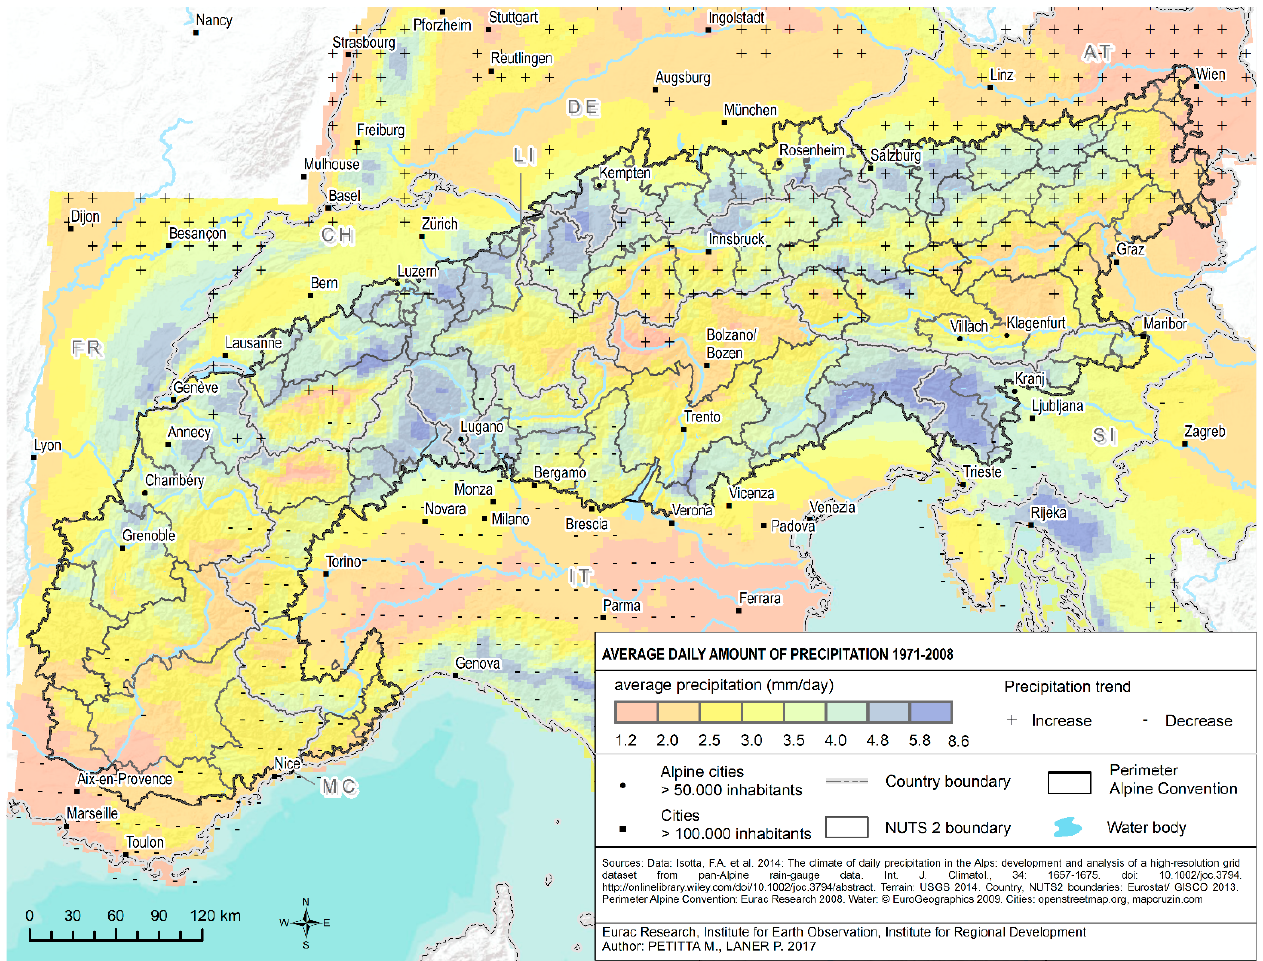
Figure 2. The average of cumulated daily precipitation 1971–2008. Source: Eurac Research, Permanent Secretariat of the Alpine Convention, 2017 [50]. Reprinted with the permission of the author.